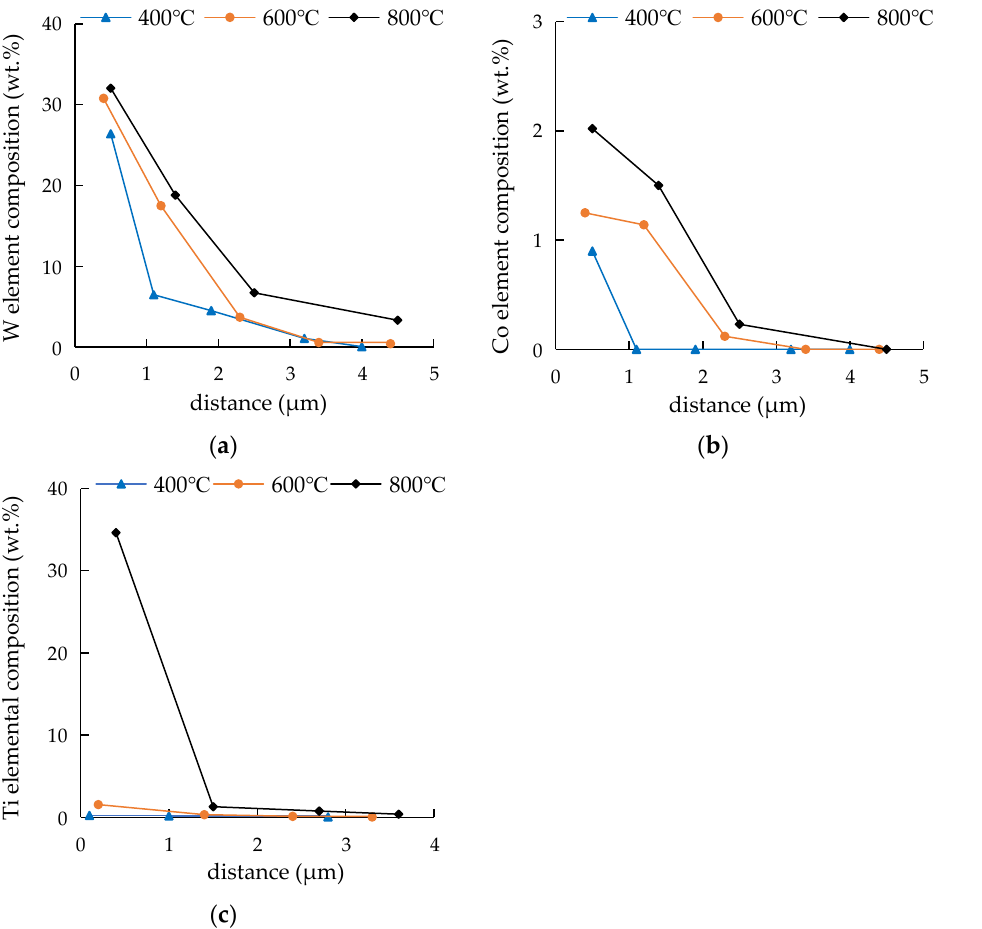
Figure 8. Element diffusion between the cemented carbide and the Ti6Al4V at different holding temperatures. ( a ) Diffusion of the W element; ( b ) Diffusion of the Co element; ( c ) Diffusion of the Ti element.